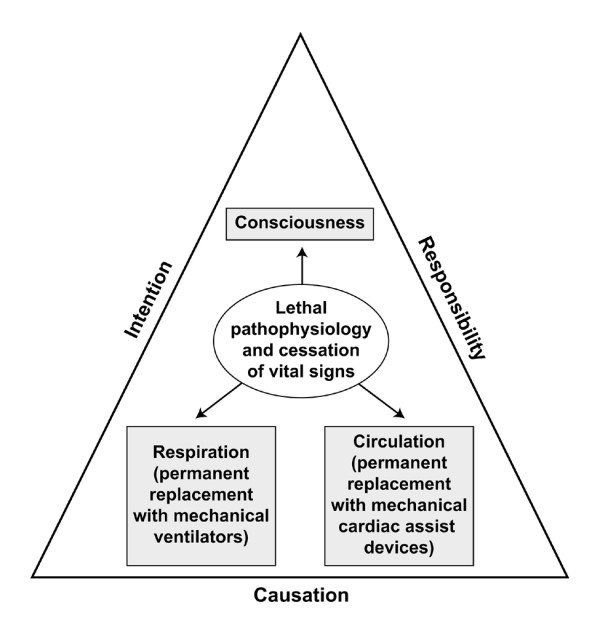
End-of-Life Discontinuation of Destination Therapy with Ventilatory and Cardiac Support Medical Devices. Mechanical ventilators and cardiac assist devices can replace native vital functions of respiration and circulation in destination therapy, respectively. Respiration and circulation become totally dependent on normal operation of these medical devices. Discontinuing mechanical ventilators and cardiac assist devices used as destination therapy can create nontherapeutic and lethal pathophysiological conditions and become the life-terminating events. The absence of concurrent lethal pathophysiological conditions that are set in motion by a newly developed acute life-threatening illness and/or a terminal disease, unrelated to the body function supported by these medical devices, refutes the notion that discontinuing destination therapy at the patient's or surrogate's elective request for death is simply allowing the patient to die. Assessment of intent, causation, and moral responsibility of the ensuing death upon discontinuing the medical device is consistent with physician-assisted death. Discontinuing permanent mechanical ventilators and cardiac assist devices can be viewed as allowing the patient to die if--and only if--concurrent lethal pathophysiological conditions are present that are unrelated to vital functions already supported by these medical devices. Examples of concurrent lethal pathophysiological conditions from an acute life-threatening illness and/or a chronic treatment-refractory advanced disease may include: irreversible loss of consciousness from a catastrophic neurological event, peripheral vascular collapse and shock from an overwhelming infection, multiple organ failures, refractory hypoxia from worsening lung disease or disseminated malignancy.